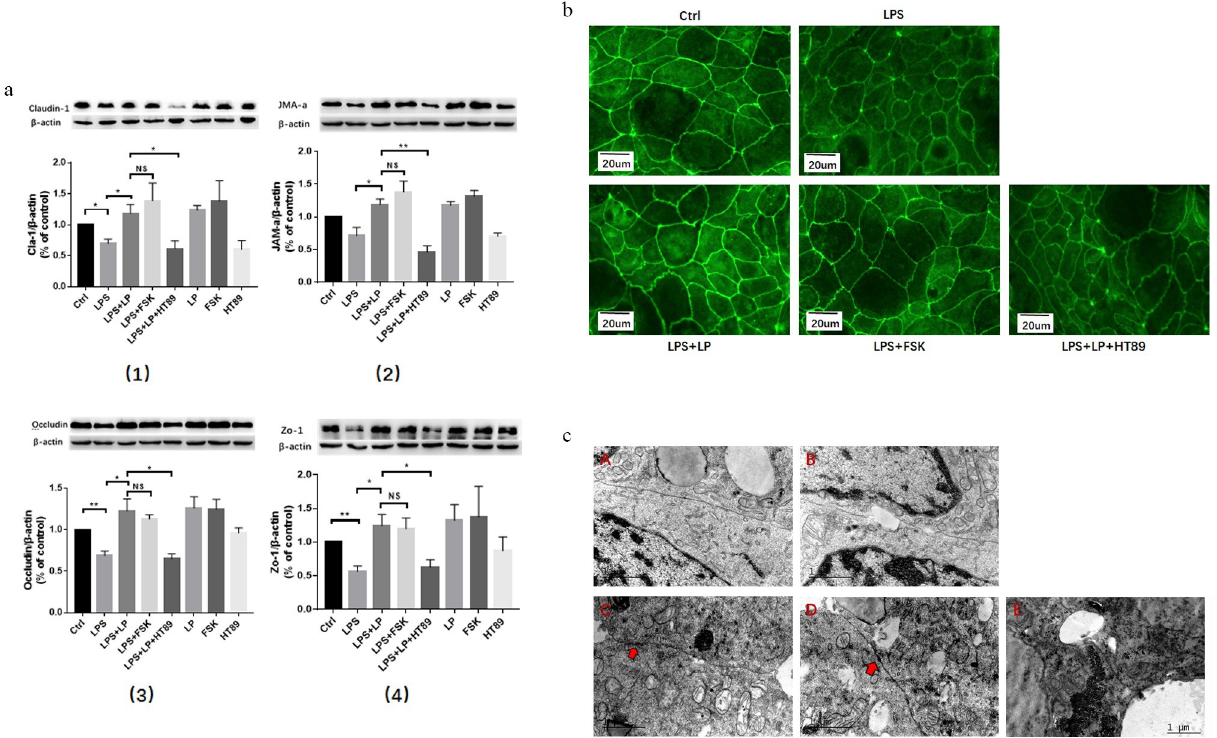
Fig 4. (a) WB detection of tight junction protein (claudin-1, JAM-a, occludin, and Zo-1) expression. Data are presented as the mean ± SD. three independent experiments were performed in duplicate. � P < 0.05 LPS + LP + HT89 group vs. LPS + LP group or LPS + LP group vs. LPS group. �� P < 0.01 LPS + LP + HT89 group vs. LPS + LP group. (b) Immunofluorescent detection of the expression and distribution of the tight junction protein, ZO-1. three independent experiments were performed in duplicate. (c) Electron microscopy-observed changes of the tightly connected ultrastructure of cells between groups. Arrows indicate the tight connection of Caco2 cells in each group. A: Ctrl group, B: LPS group, C: LPS + LP group, D: LPS + FSK group, E: LPS + LP + HT89 group. three independent experiments were performed in duplicate.